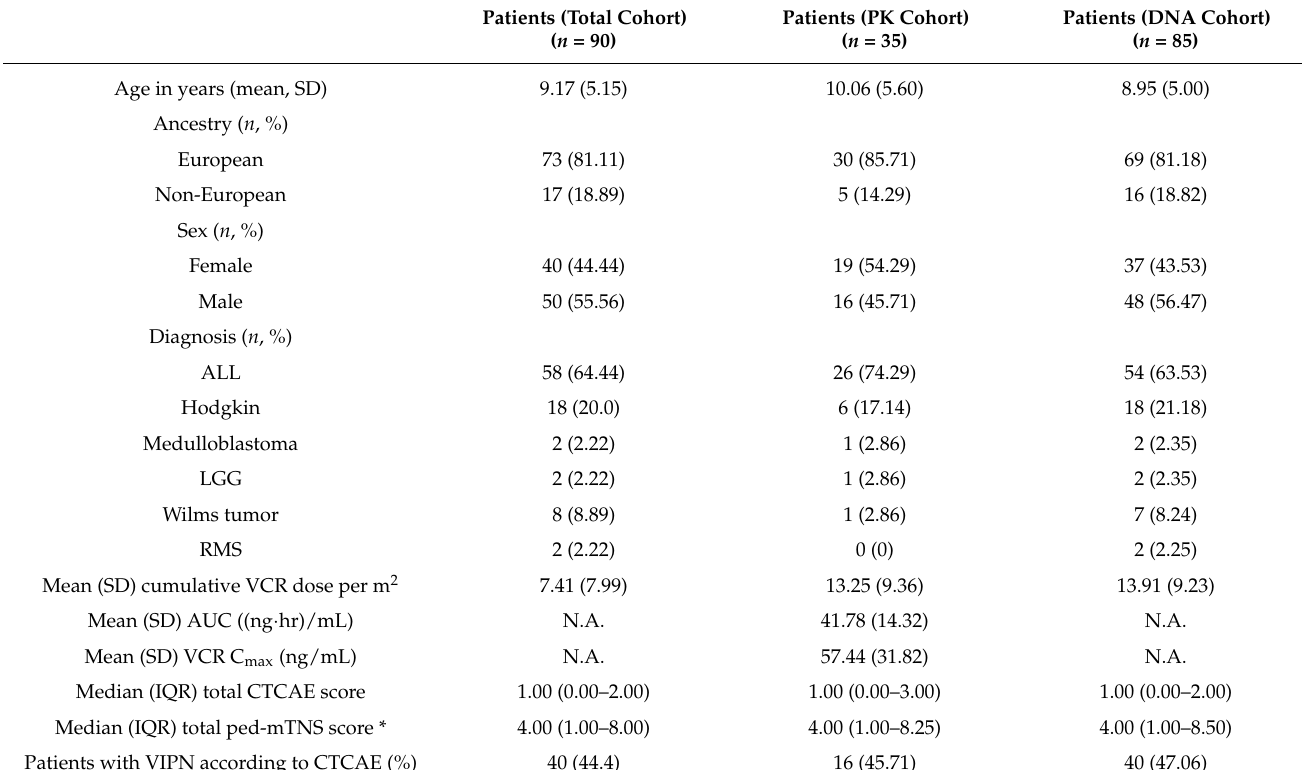
Table 1. Patient characteristics of the included